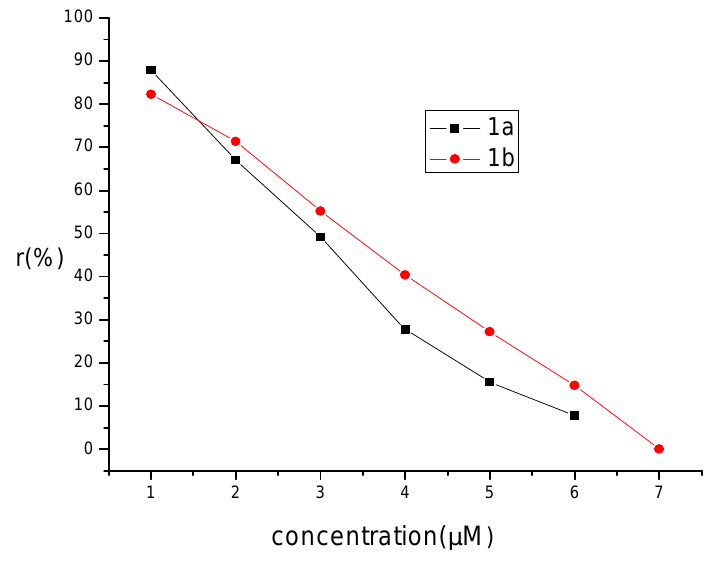
Figure 5 . Fluorescence quenching curve of complexes at different